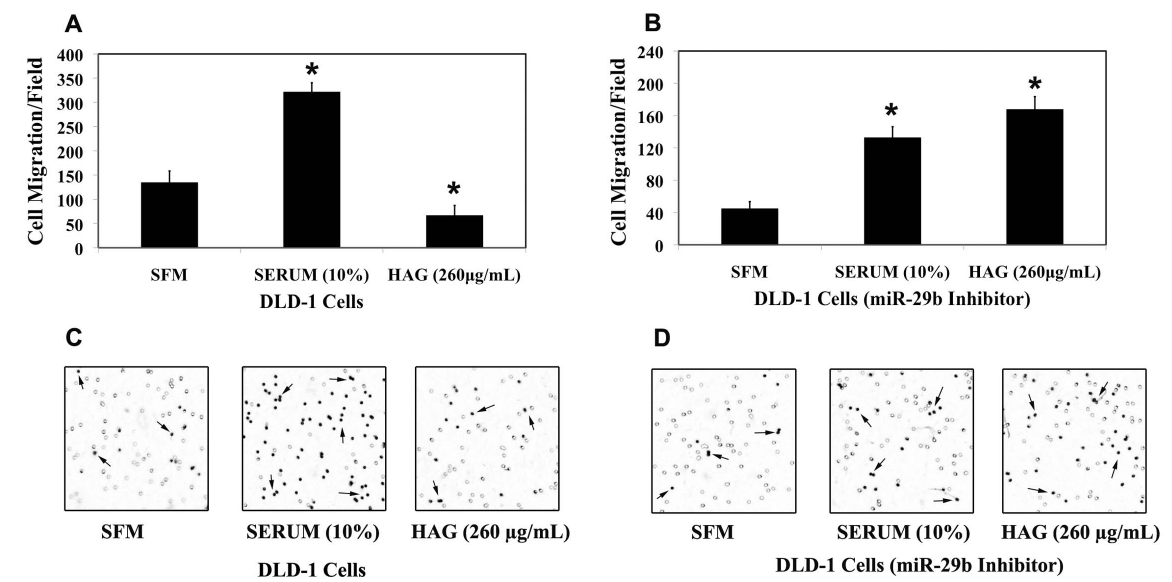
Figure 4. Hexane fraction of American Ginseng (HAG) represses DLD-1 colon cancer cell migration invitro. Collagen type-I (15 m g/mL) coated transwell chamber were applied with 5 6 10 4 DLD-1 cells (A/B) for 12 h. The lower chamber contains SFM/Serum (10%) or HAG (260 m g/mL in complete medium). (A) 5 6 10 4 DLD-1 WT cells were applied to the upper chamber of the transwell membrane. (B) 5 6 10 4 DLD-1 (transfected with mirvana miR-29b, 10 nM, 48 h) cells were applied to the upper chamber of transwell membrane. After 12 h incubation at 37 u C, the cells migrated to the inside (lower membrane) of transwell membrane was counted using ImageJ software (7 random microscopic fields (100X) were evaluated for cell counting). (C) Depicts the representative picture of DLD-1 WT cell migration from each treatment. (D) Depicts the representative picture of DLD-1 (transfected with mirvana miR-29b, 10 nM, 48h) cell migration from each treatment. The background in the picture shows the 8 m m pore in the transwell membrane. *, indicates significant difference (pvalue , 0.005) when compared to SFM.